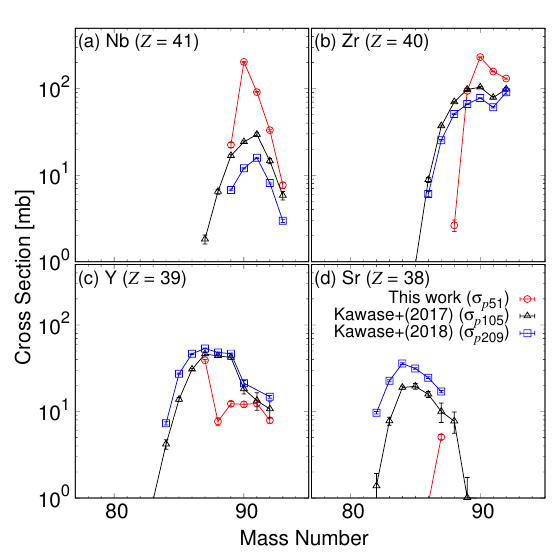
Figure 4. The same as Fig. 3, but for d -induced reac- tion at 52 MeV / nucleon with previous works at 105 and 209 MeV /